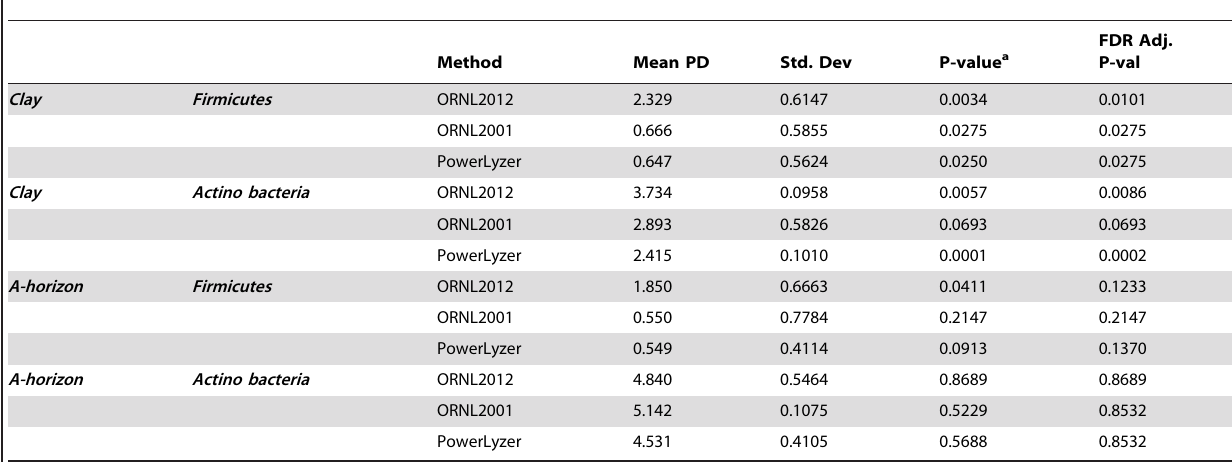
Table 3. Phylodiversity by Extraction Method for Selected